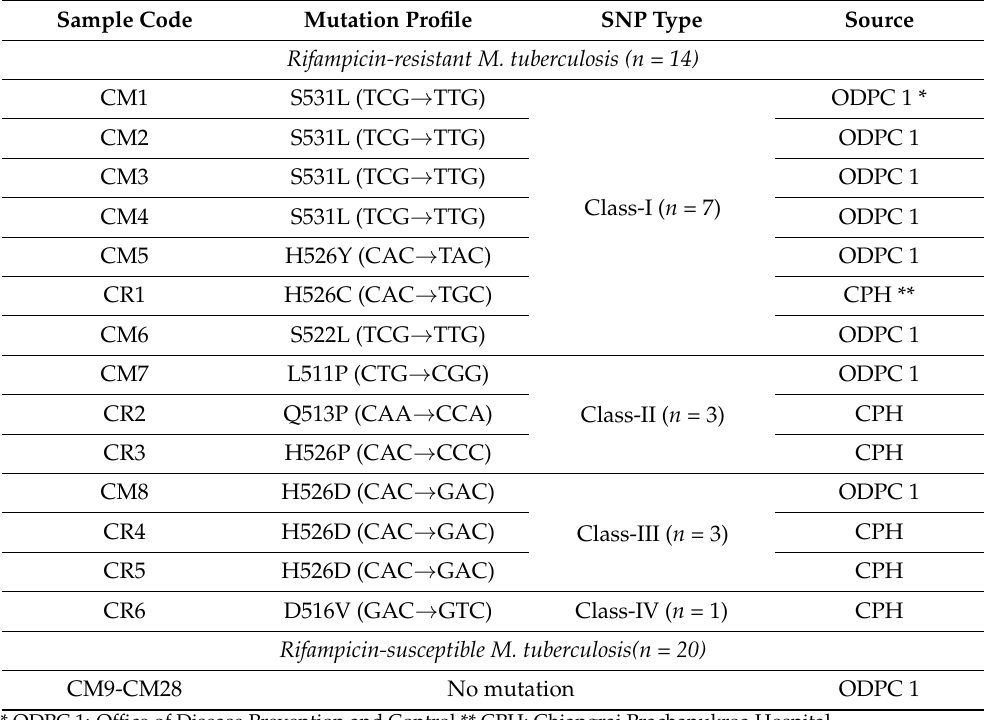
Table 1. Mycobacterium tuberculosis isolates used in the validation process of the RIF-RDp